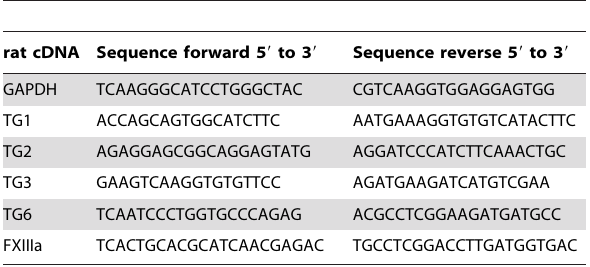
Table 1. Oligonucleotide primers used for amplification of cDNAs 1